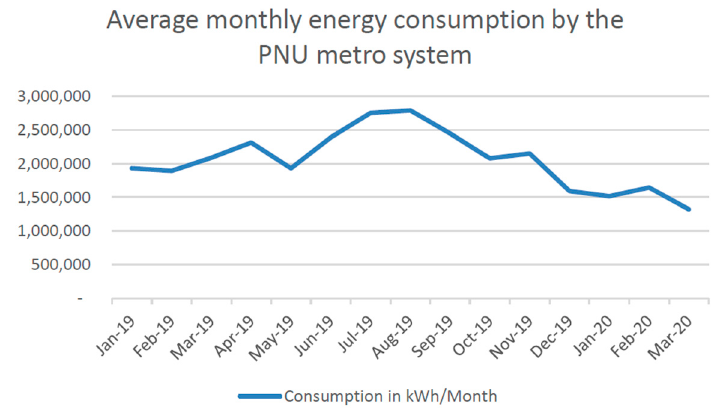
Figure 2. Average monthly energy consumption by the PNU metro system from the period of January